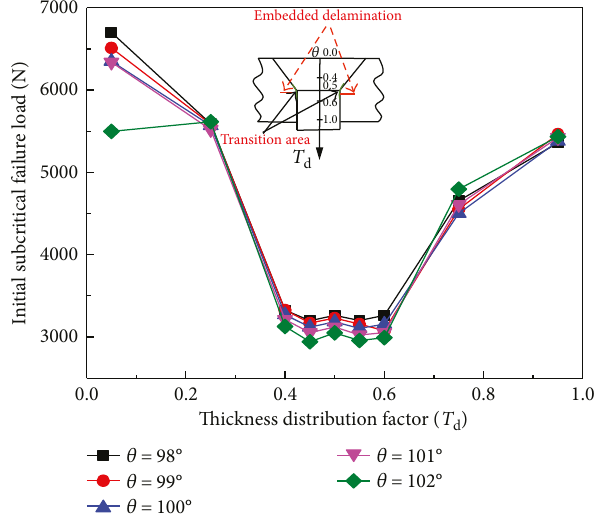
Figure 16: E ff ect of T on the initial subcritical failure load under d di ff erent countersunk-head